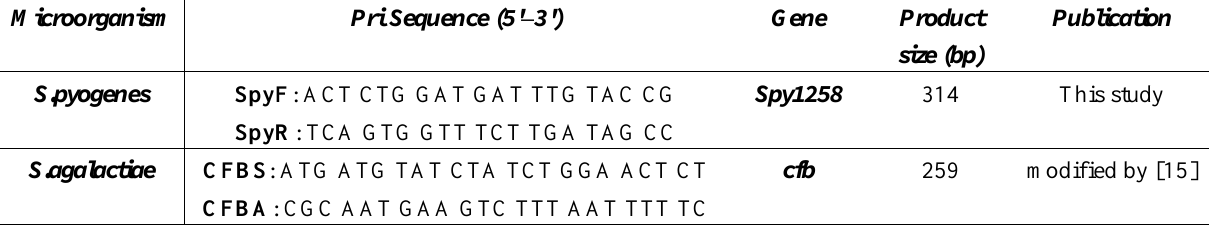
Table 1. Oligonucleotide primers used in multiplex PCR assay for the identification of Streptococcus pyogenes and Streptococcus agalactiae .